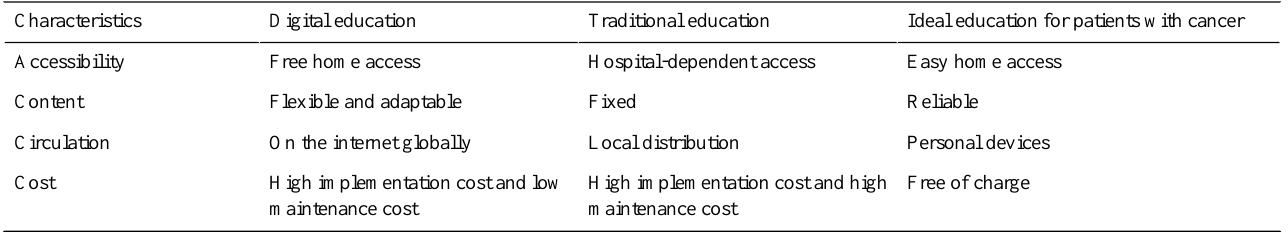
Table 2. Comparison among different media of patient